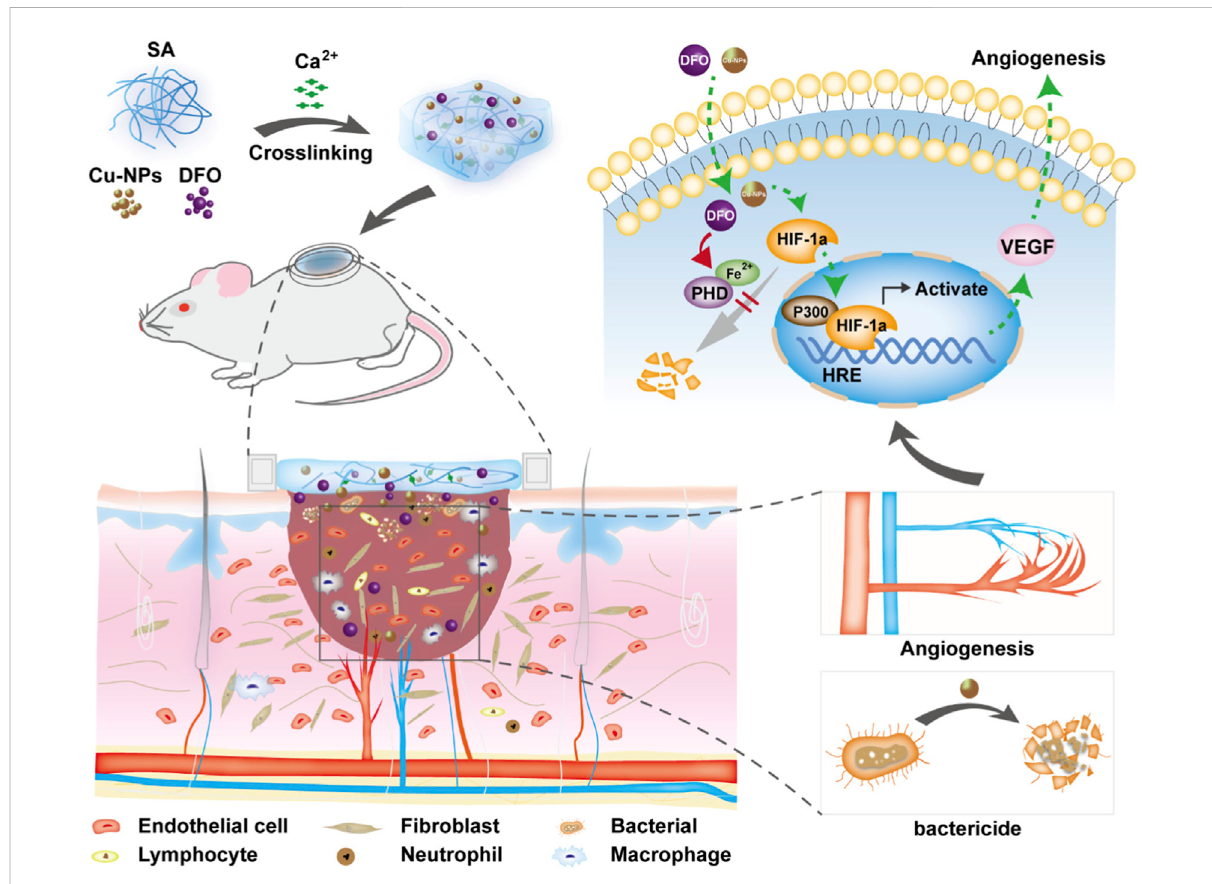
FIGURE 1 Schematic diagram of the strategy for the treatment of diabetic wound healing using bioactive hydrogel composites containing deferoxamine and copper nanoparticles. Reproduced from (Li et al., 2022b), with permission from Elsevier.